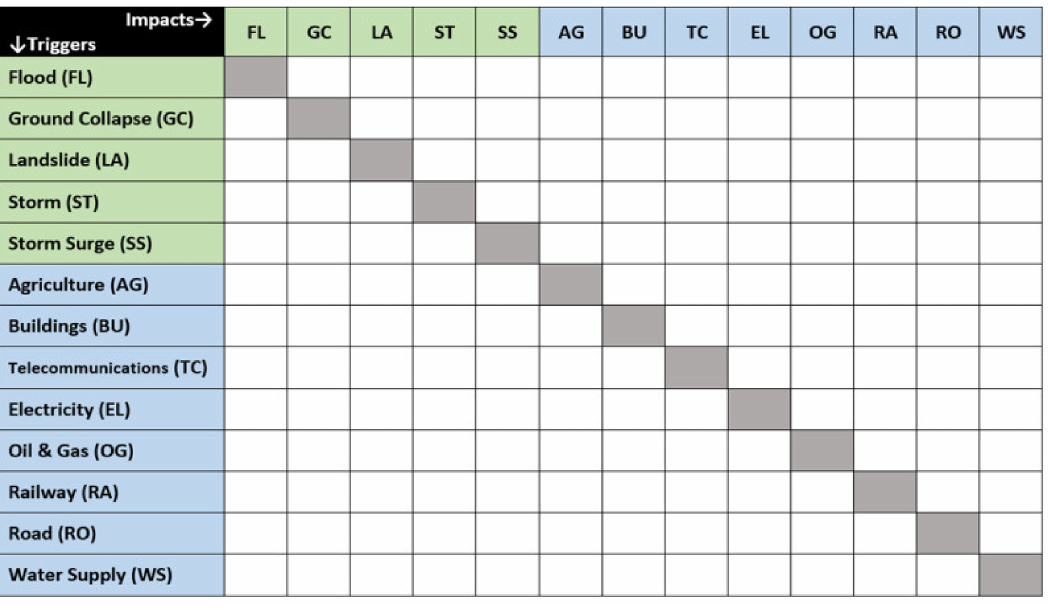
Figure 6. Matrix showing values for expert rating as blank white